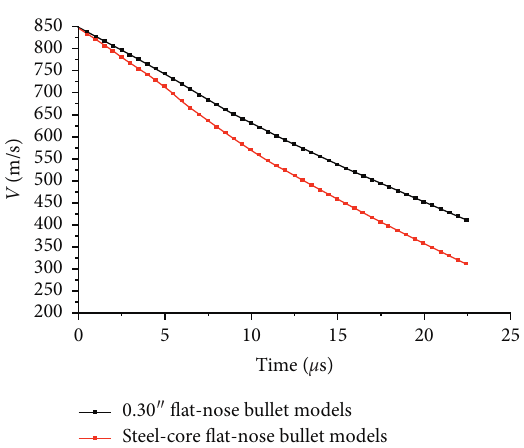
Figure 14: Velocity-time diagram of the bullet (5% 333 FGM + 4mm Al